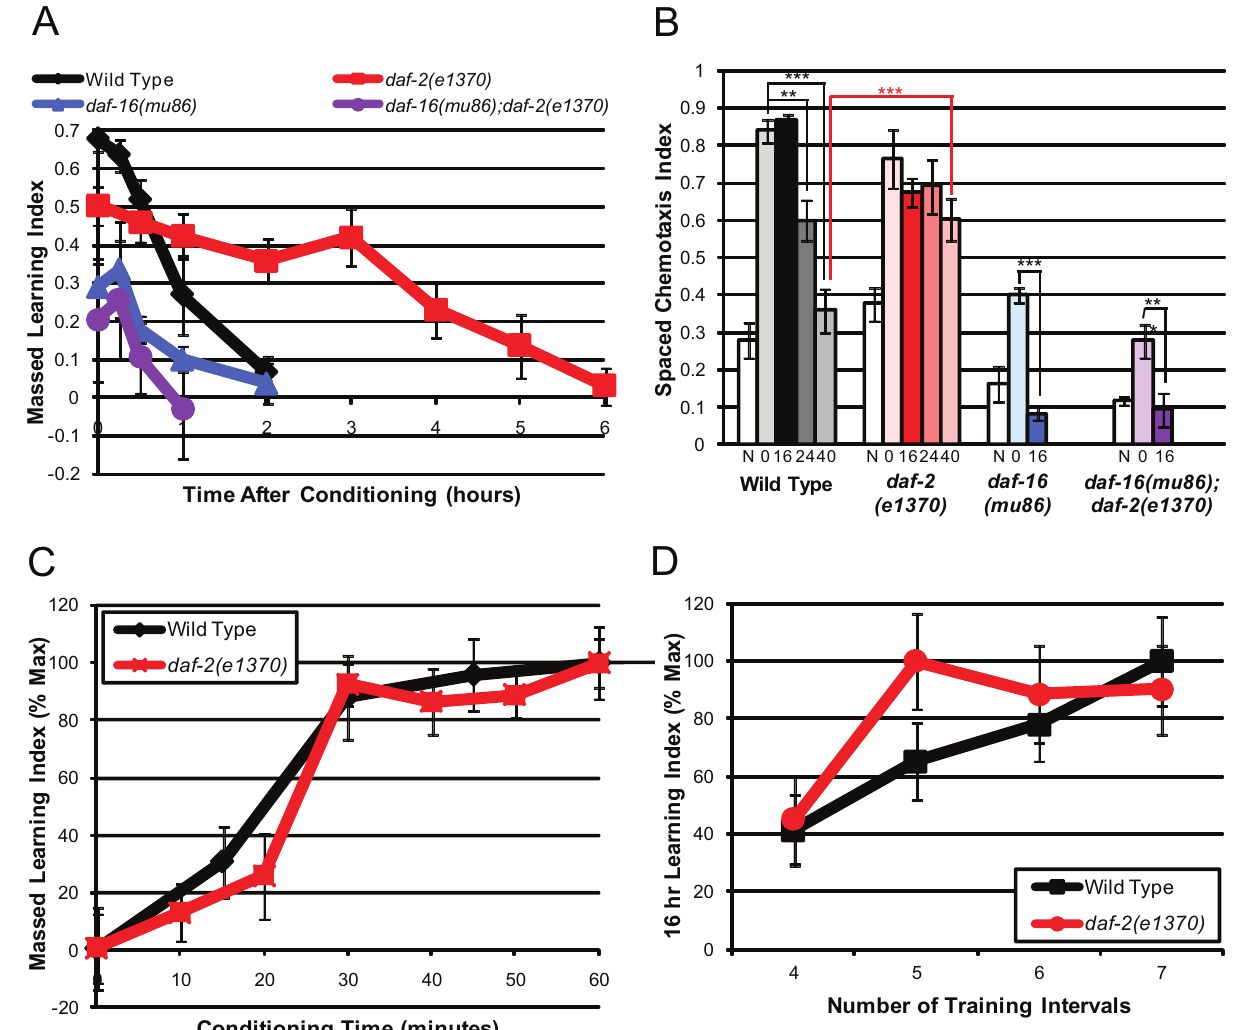
Figure 5. Insulin signaling mutants increase Day 1 adult memory. (A) After massed training, daf-2(e1370) mutants retain short-term memory more than three times as long as wild type, in a daf-16 -dependent manner. (B) After spaced training, daf-2(e1370) mutants maintain long-term associative memory significantly longer than wild type, also dependent on daf-16 . N = naı¨ve, numbers under bars represent hours after 7 6 spaced training. (C) daf-2(e1370) mutants learn at the same rate as wild-type after massed training. (D) daf-2(e1370) mutants form 16 h memory faster with spaced training than wild-type. (A–D): n =6 trials; 6 SEM; ** p , 0.01, *** p , 0.001.